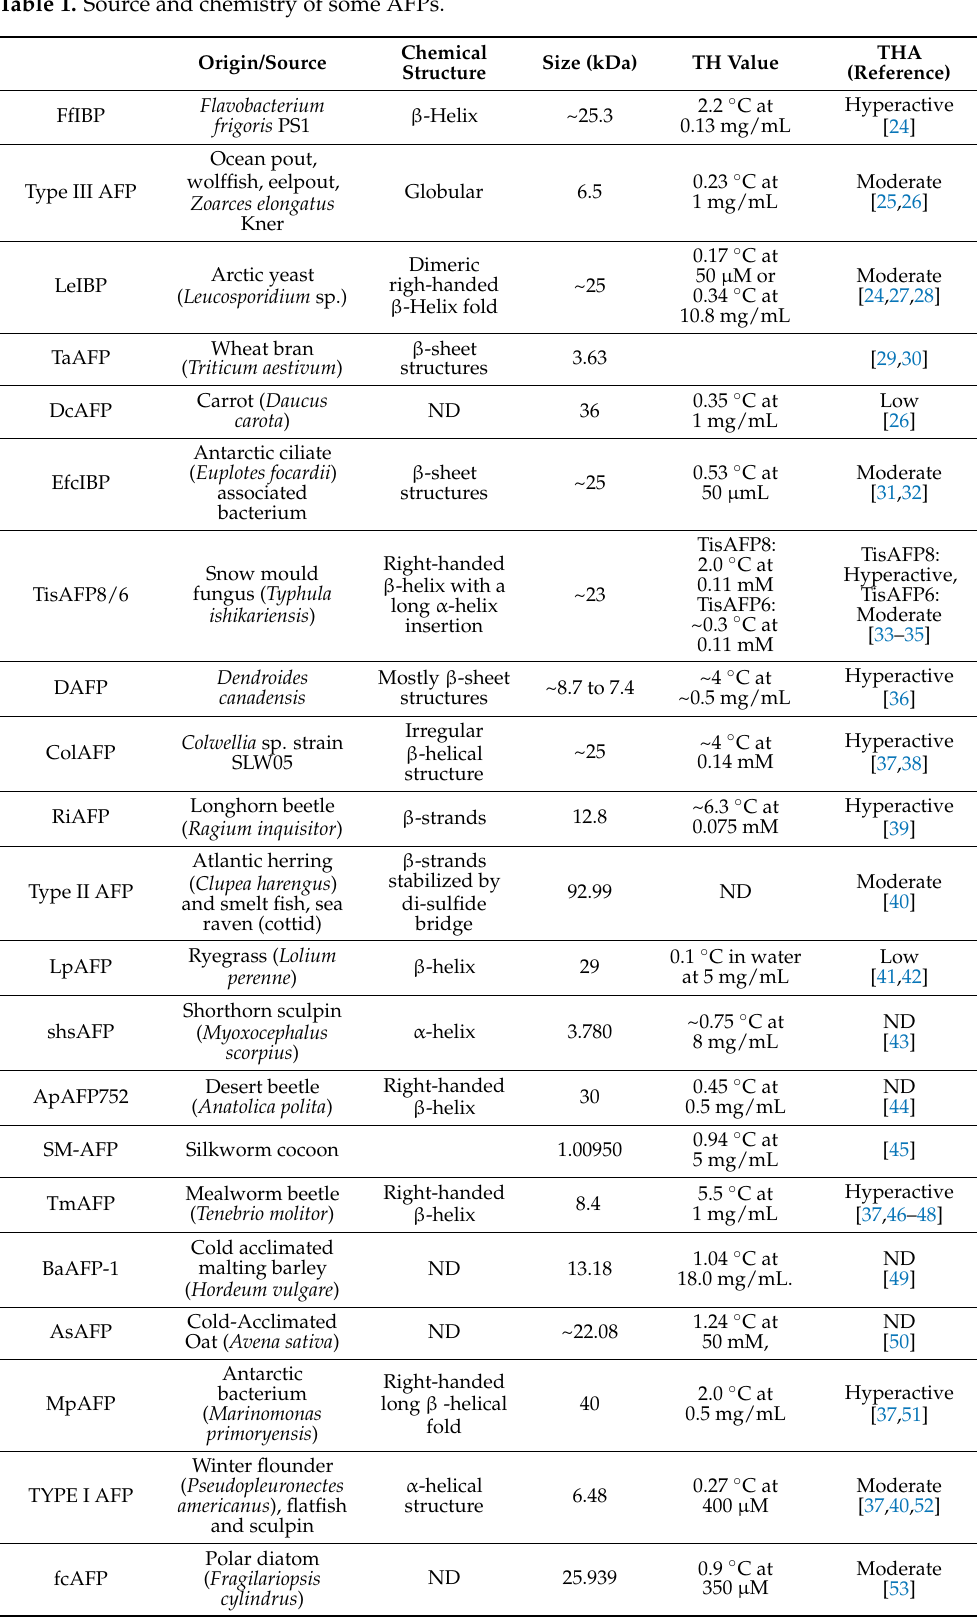
Table 1. Source and chemistry of some